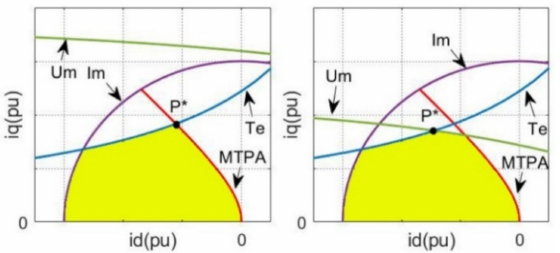
Figure 4. Primal optimization problem for FW. Um: voltage limitation; Im: current limitation; Te: electrical torque trajectory; MTPA: MTPA trajectory.